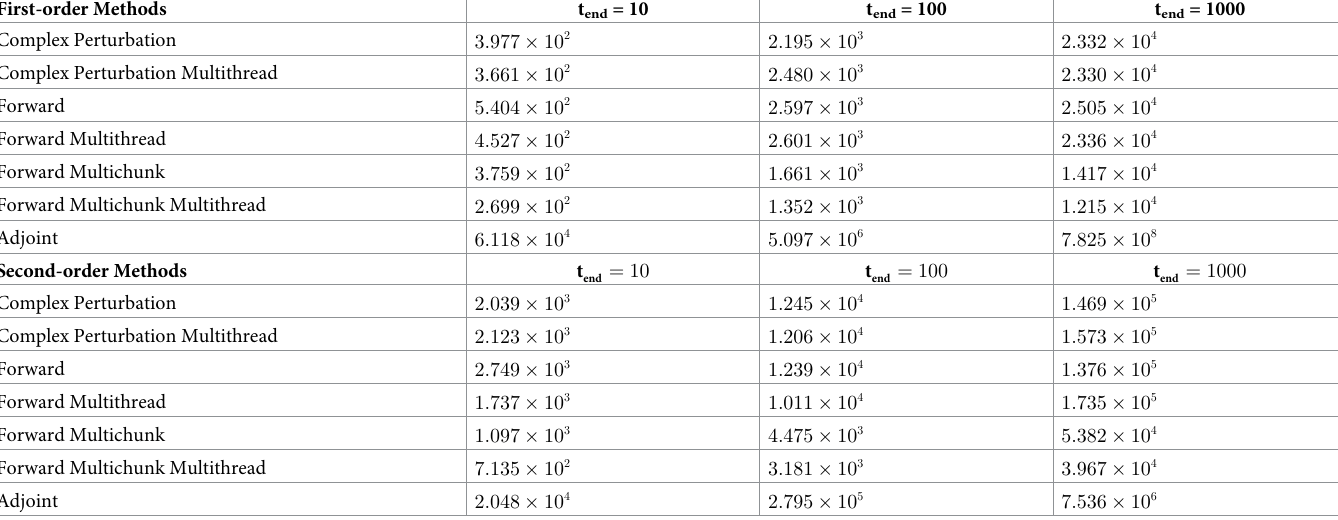
Table 3. Computational time ( μ s) for the CARRGO ODE model. Parameters match those previously introduced in this manuscript. Multithread refers to parallel- ism across parameters. Multichunk refers to parallelism across compartments. We invoke the Julia solver AutoVern9(Rodas5(autodiff = false)) with a tolerance of 1 × 10 − 5 , reflecting the convergence tolerance. For the second-order adjoint method, the ForwardDiffOverAdjoint(QuadratureAdjoint(autodiff = false) solver option was